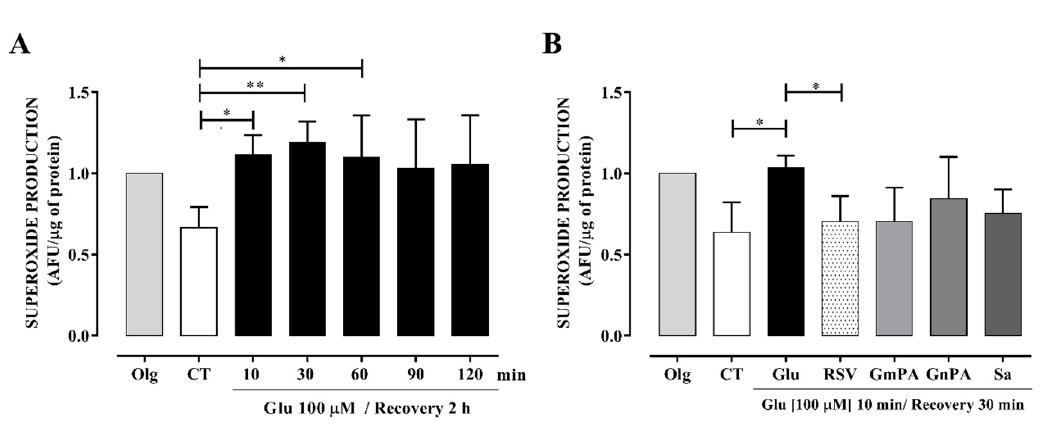
Figure 3. Reduction of intracellular superoxide (O 2 • − ) levels on neuronal cultures treated with extracts obtained from the Geraniaceae and Lamiaceae families. Primary neuronal cultures were stimulated with 100 μ M glutamate (Glu) to induce excitotoxicity. O 2 • − production was evaluated using dihydroethidium dye. ( A ) Time course of O 2 • - production after excitotoxicity. The neuronal culture was exposed to glutamate for different periods (10, 30, 60, 90, and 120 min) and then allowed recovery for 2 h. ( B ) Effect of extracts on O 2 • − levels. Neuronal cultures were exposed to 10 min of excitotoxicity and after extracts were added for 30 min. CT, control cultures not stimulated with Glu; Olg, cultures treated with oligomycin; GmPA (0.001 μ g/ μ L), Geranium mexicanum ; GnPA (0.0001 μ g/ μ L), Geranium niveum ; Sa (0.0001 μ g/ μ L), Salvia amaríssima ; Sp (0.01 μ g/ μ L), and Salvia polystachya ; Resveratrol (RSV), arbitrary fluorescence units (AFU). Results are expressed as mean ± SEM; ANOVA: Specific groups that showed differences against the CT or Glu group are indicated with the upper bar. ** p < 0.001, * p < 0.05.